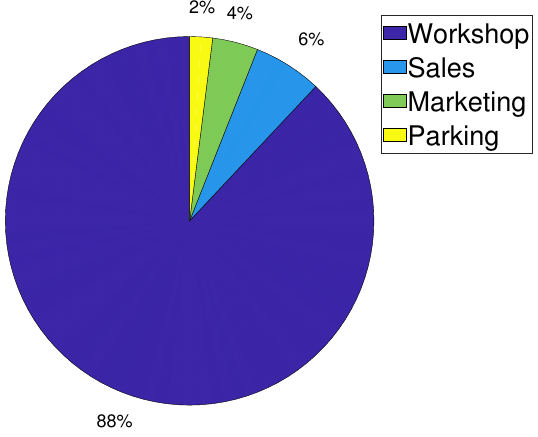
Figure 3. Electricity energy use share by